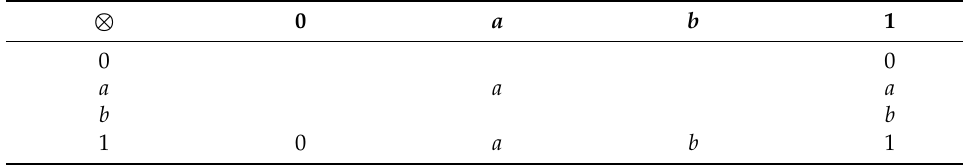
Table 5. The operation ⊗ .